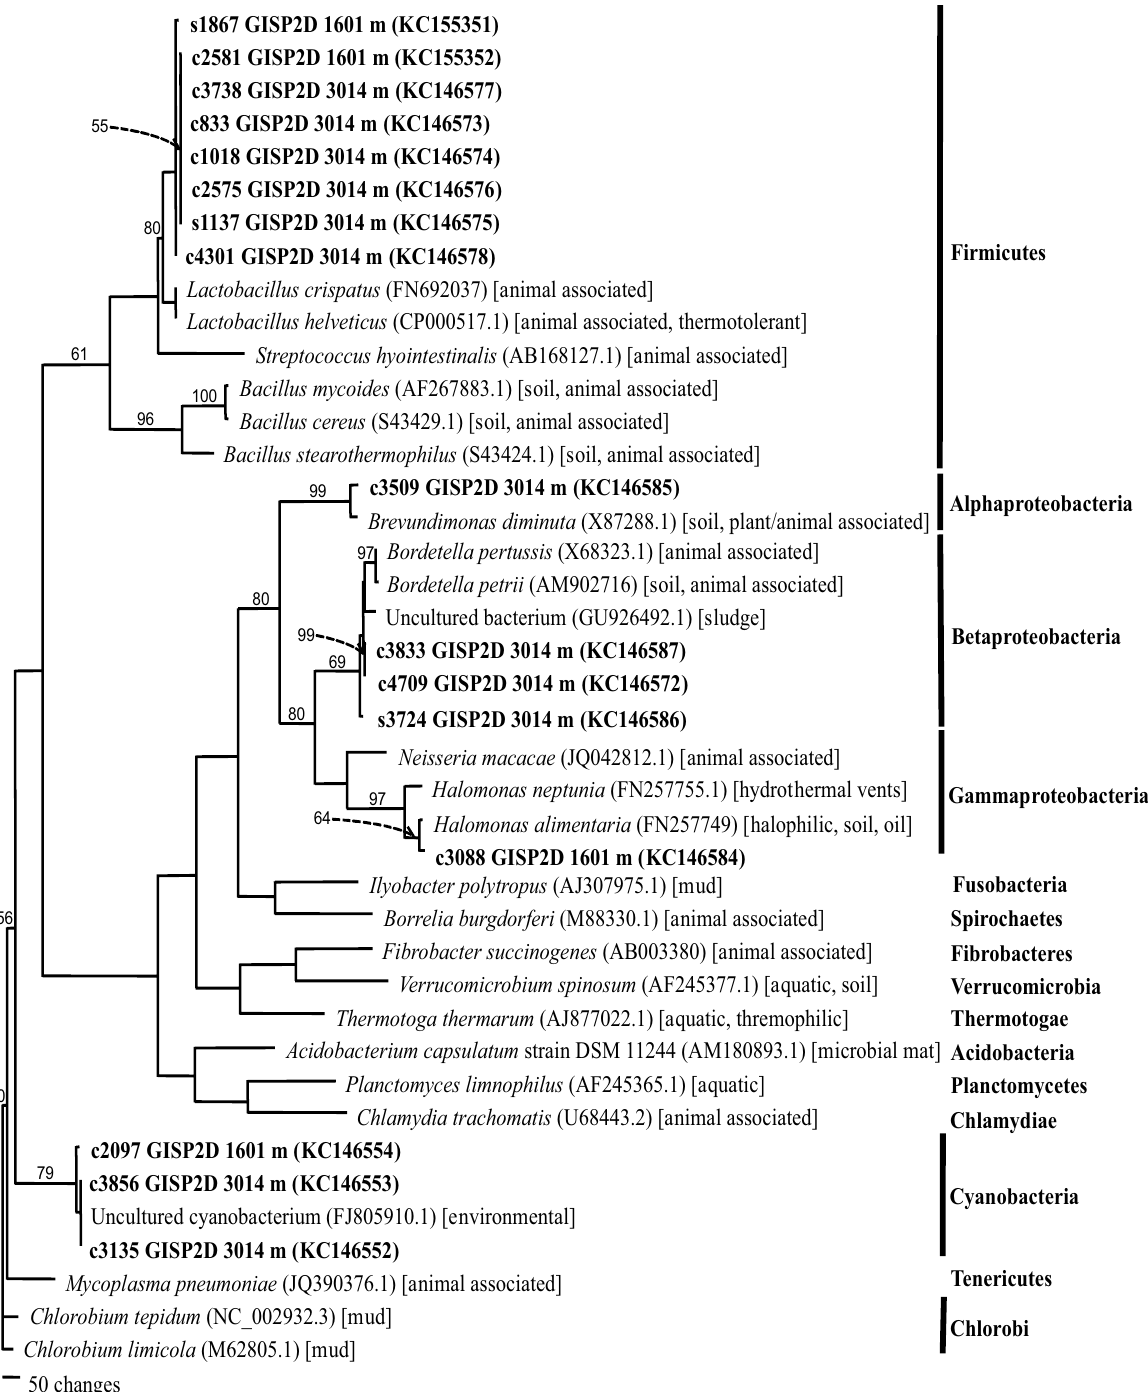
Figure 7. Phylogram of bacterial large subunit rRNA (LSU rRNA) sequences (maximum parsimony using PAUP [30]) from the GISP2D ice core. Sequences determined in this study are indicated in bold font. Ice core location and depth (meters below the glacial surface) are indicated for each. Phyla are on the right. The closest NCBI sequences to the queried sequences were selected from BLAST search results for use in the phylogenetic analysis. NCBI accession numbers (in parentheses) and sources of isolates (square brackets) are provided. Bootstrap values (1,000 replications) are given for branches with support greater than